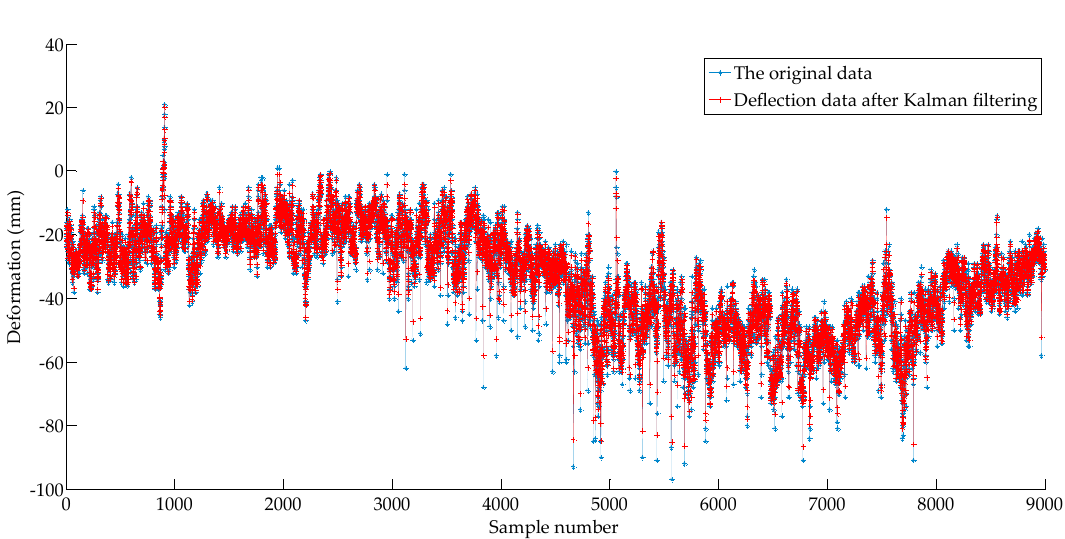
Figure 6. The deflection sample series after the Kalman filter.